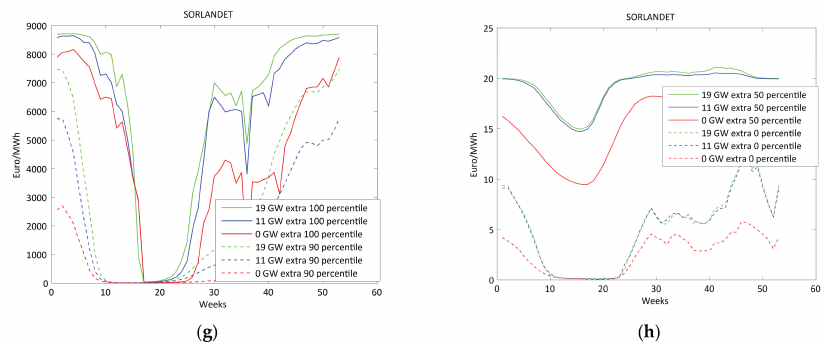
Figure 3. Water values for the four regions in Norway with increases in generation capacities. ( a , c , e , g ) shows the 100 and the 90 percentiles while ( b , d , f , h ) shows the 50 and 0